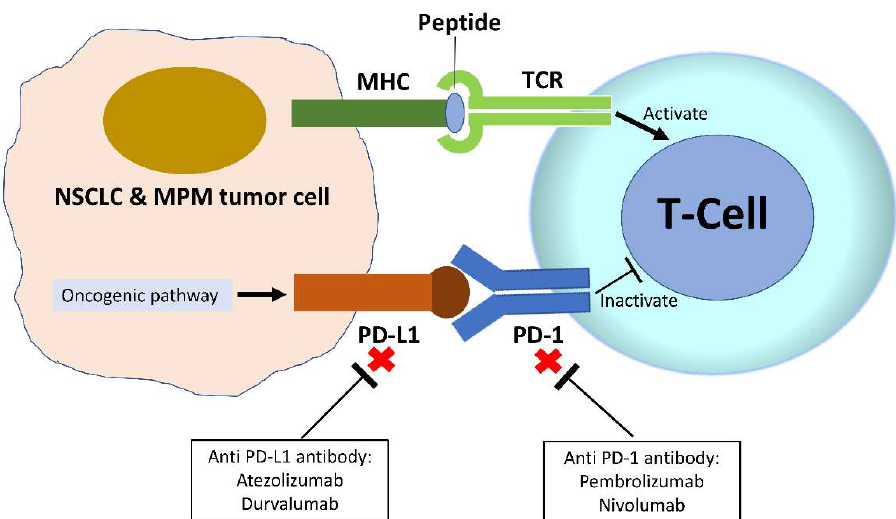
Figure 1. The mechanism of anti-programmed death-ligand 1(PD-L1)/PD-1 inhibitors in cancer therapy. In tumor cells, including non-small cell lung cancer (NSCLC) and malignant